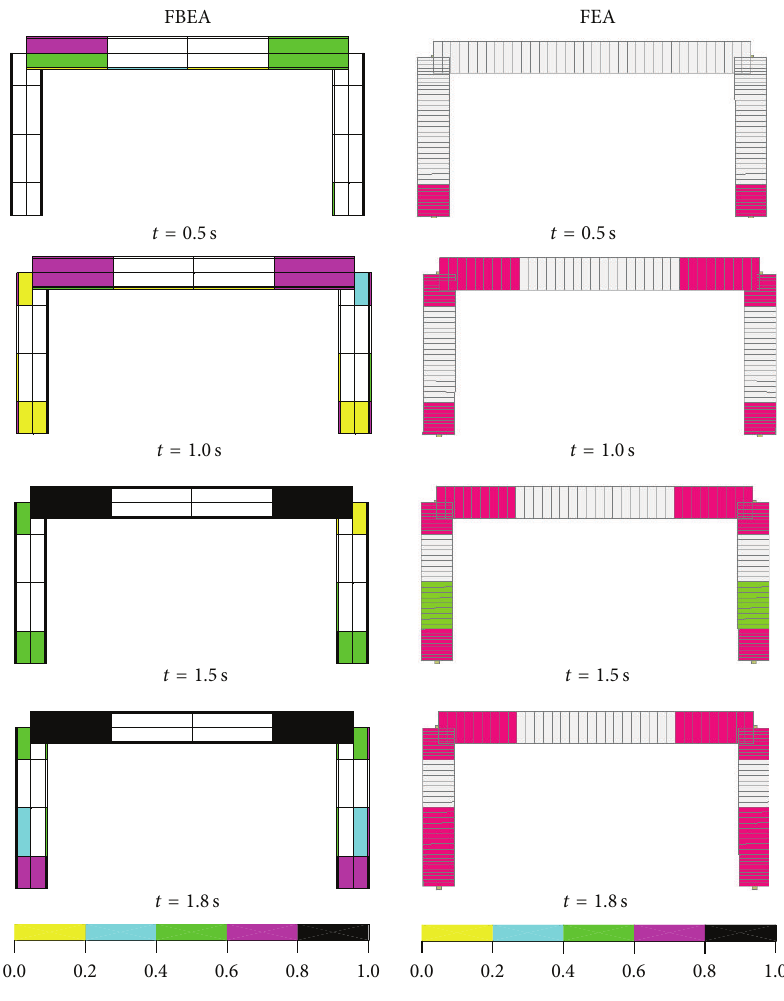
Figure 9: Accumulated tensile damage zones of the portal frame.